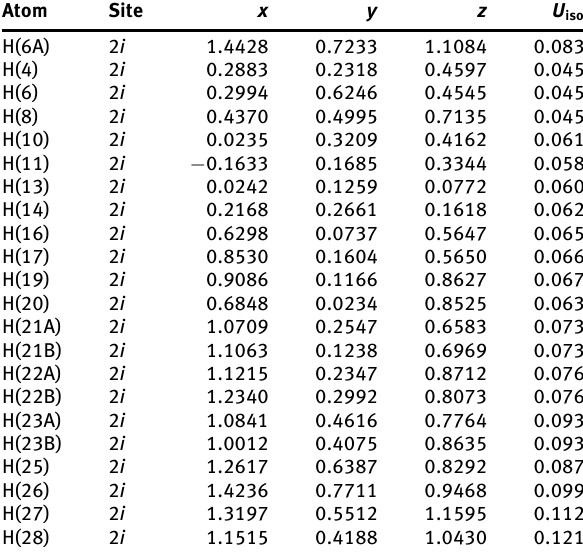
Table 2: Fractional atomic coordinates and isotropic or